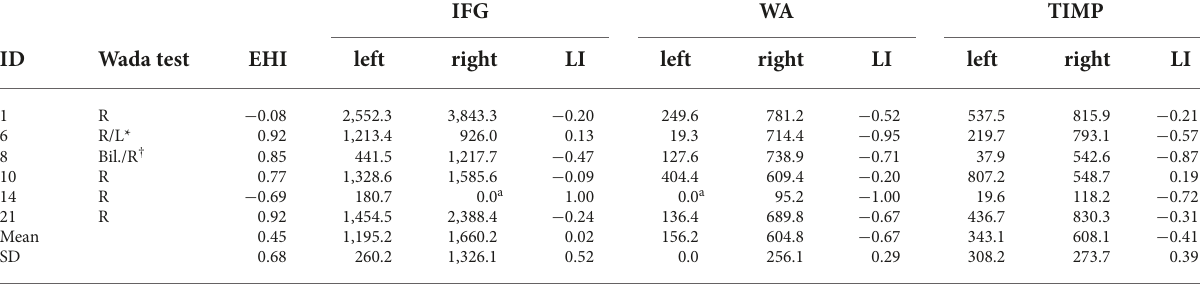
TABLE 7 fMRI laterality indices and sum of threshold surviving t -values in patients with atypical language dominance revealed by Wada test ( p < 0.001, extended to 10 voxels). IFG WA TIMP ID Wada test EHI left right LI left right left